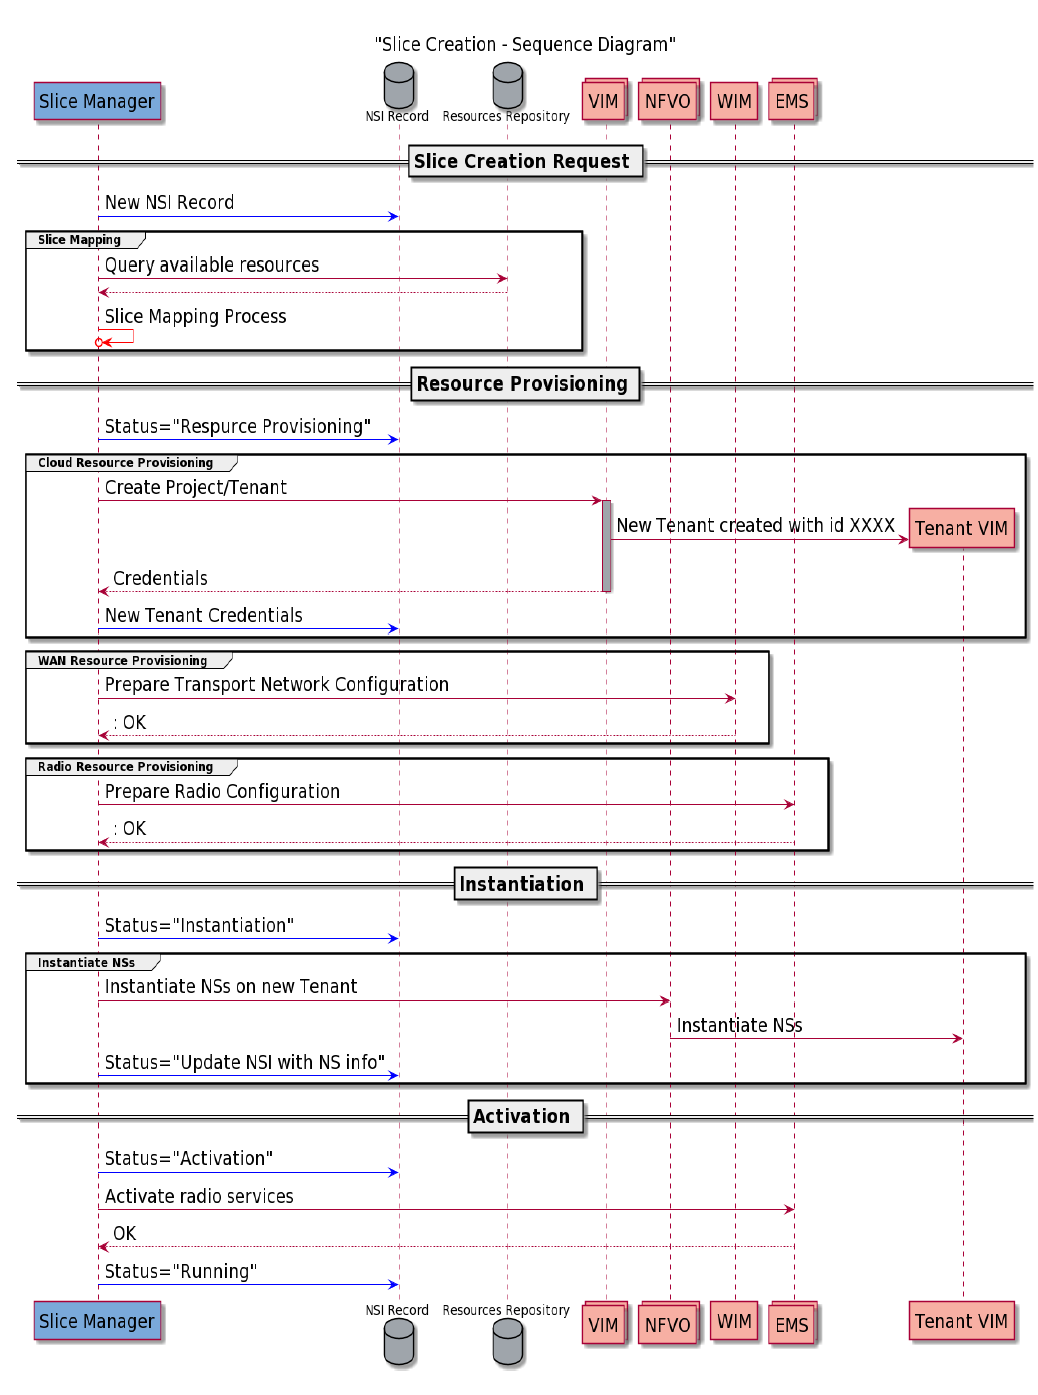
Figure 2. Sequence diagram of slice creation.